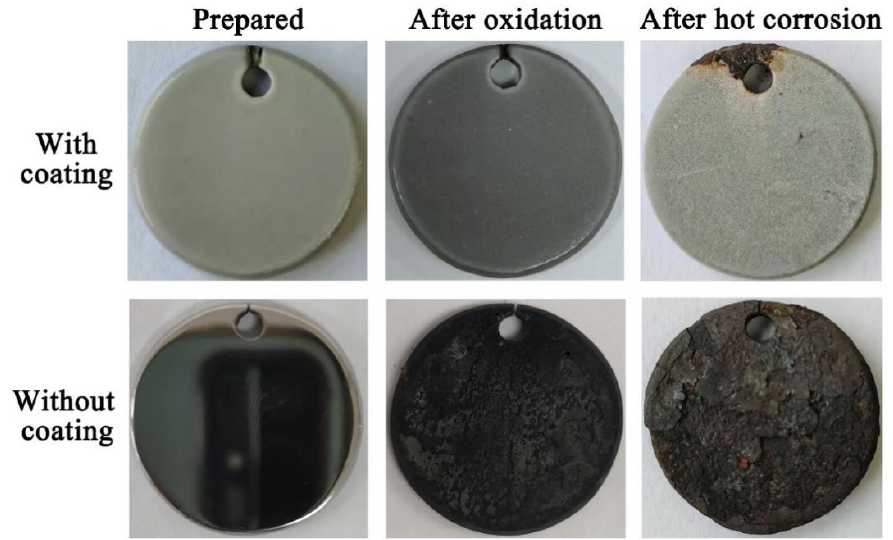
Figure 2. Macromorphology of MSS with and without GCC in as prepared state, after oxidation and hot corrosion at 650 ◦ C for 100